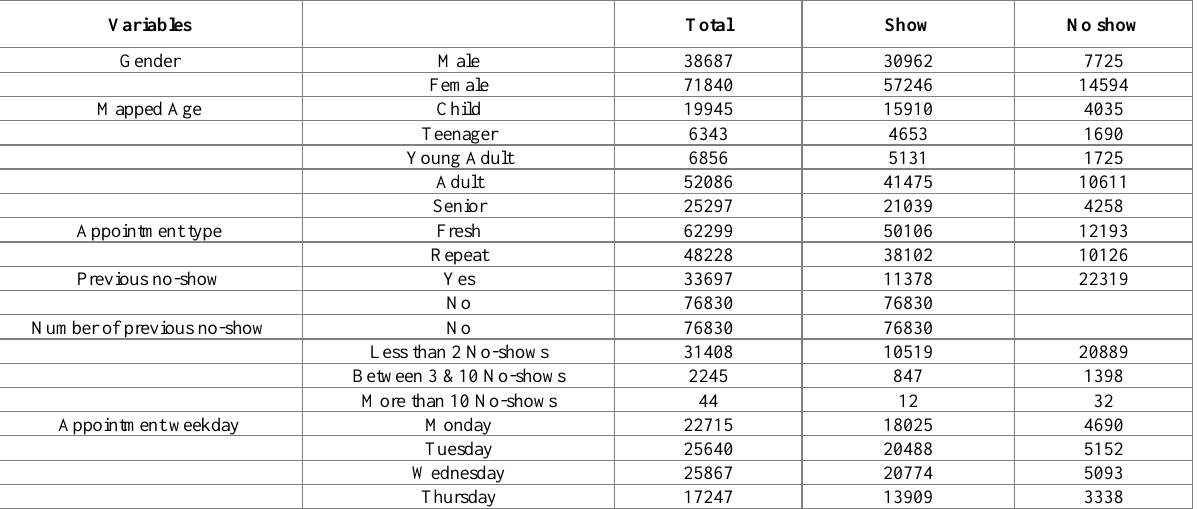
Table 1. Descriptive analysis of variables to